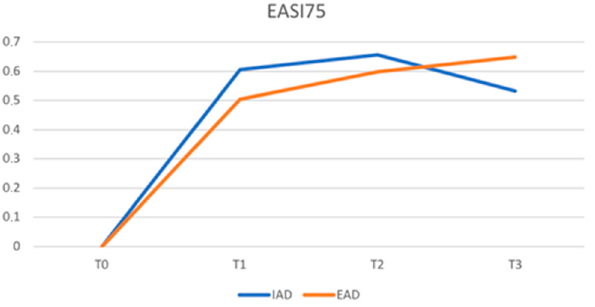
Figure 1. Proportion of patients achieving a 75% improvement in the eczema area and severity index (EASI75) (IAD = intrinsic atopic dermatitis; EAD = extrinsic atopic dermatitis).